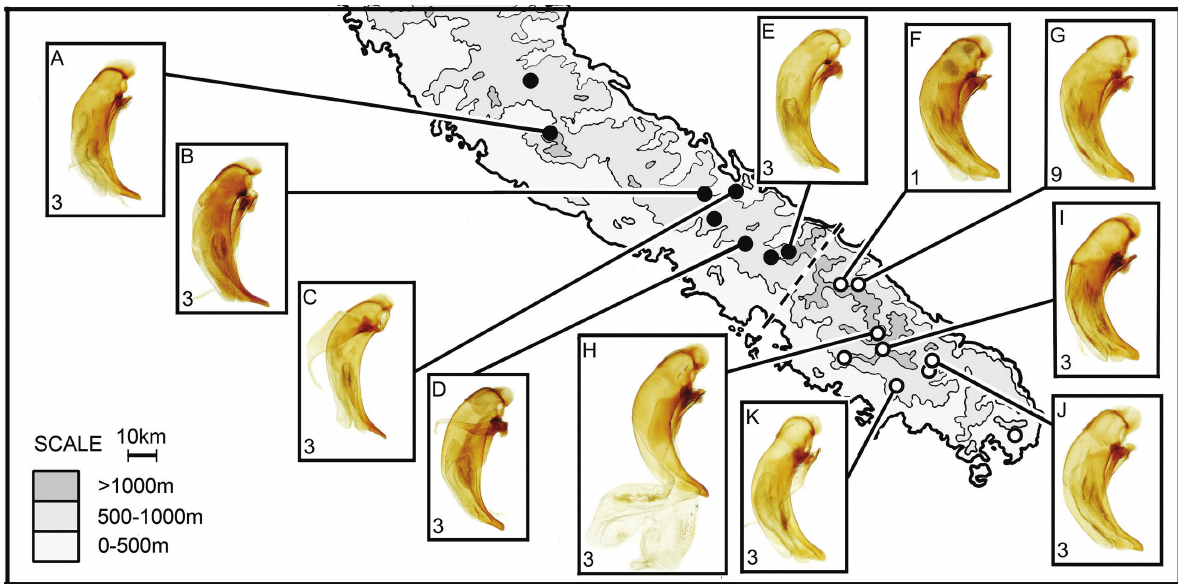
Figure 15. Recorded geographical distribution of M. fleutiauxi (including population samples A–E northwest of dashed boundary) and M. jeanneli (including population samples F–K southeast of dashed boundary): numbers of males sampled for each locality in - dicated in lower left of boxes. Sampled population localities for M. fleutiauxi include: A , Me Maoya; B , Rembai; C , Gelima; D , Mt. Do; E , Ningua. Sampled population localities for M. jeanneli include: F , Mt. Humboldt, 600 m; G , Mt. Humboldt, 1300–1600 m; H , Mt. Ouin; I , Mt. Dzumac; J , Rivière Bleue; K , Mts.